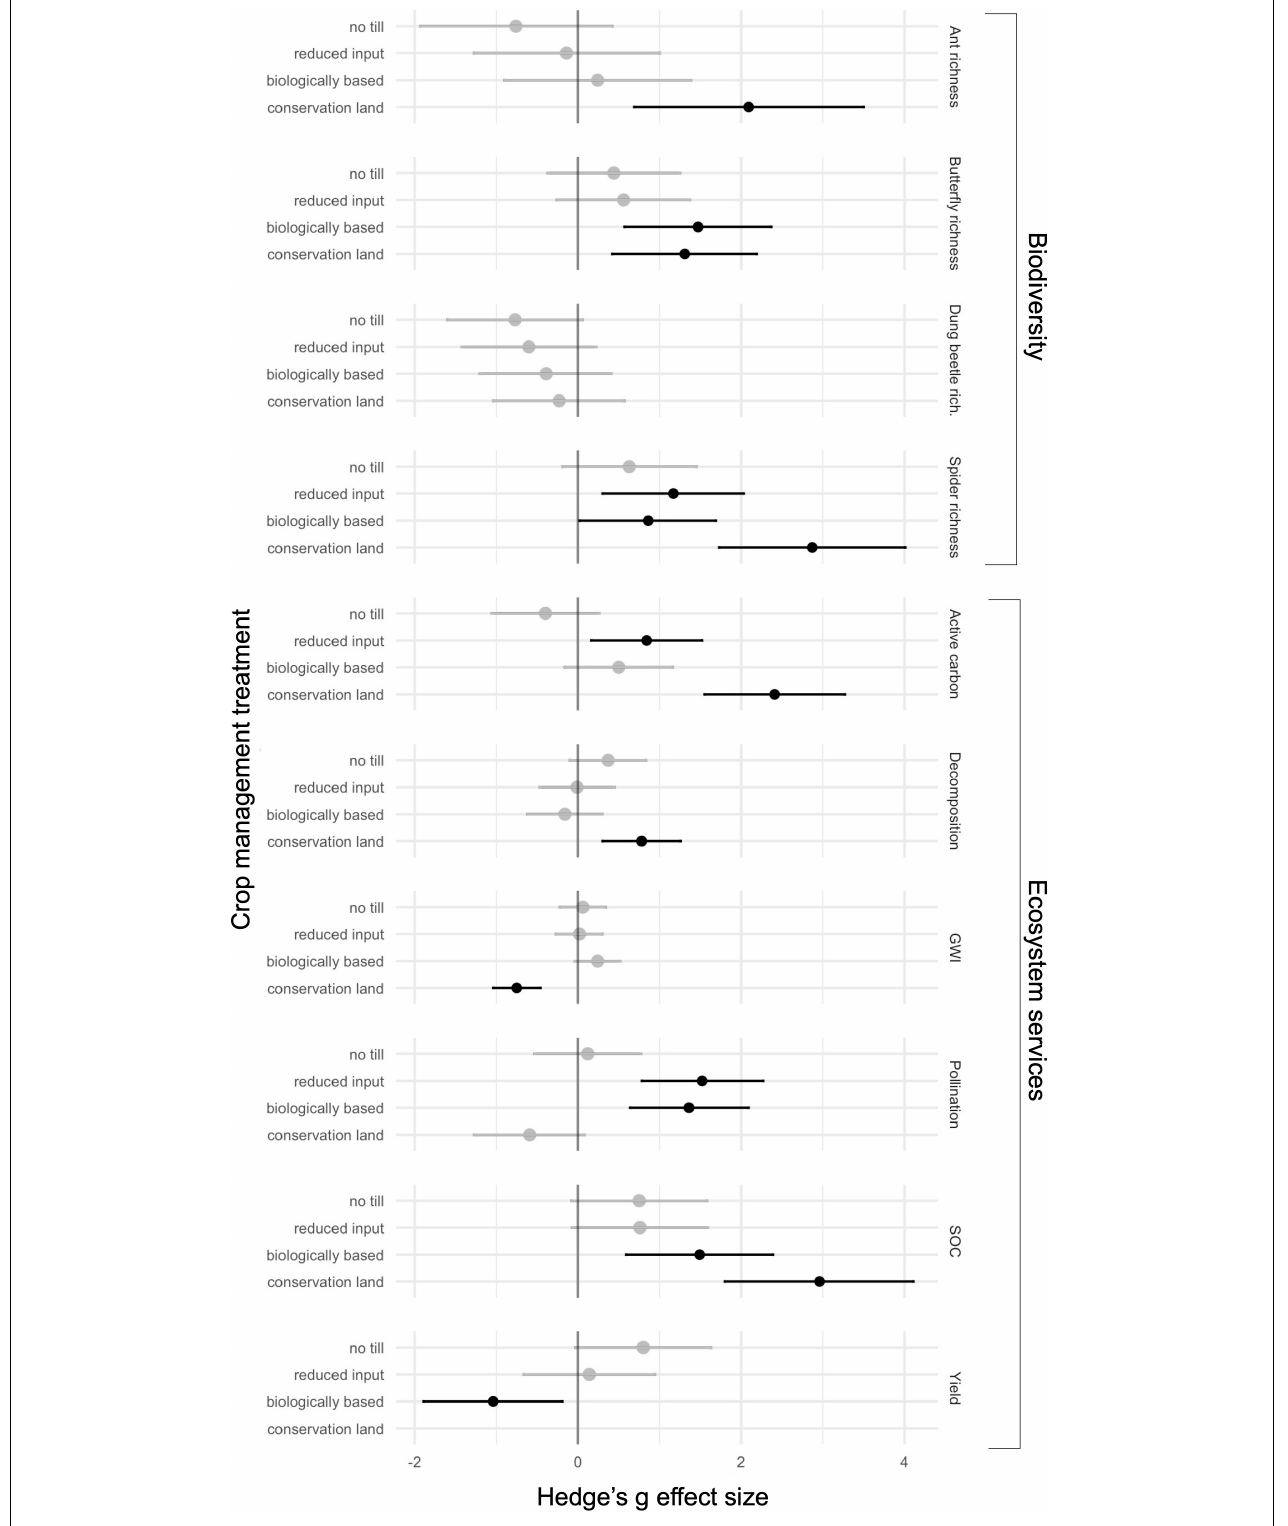
FIGURE 2 | Hedge’s g effect size (black and gray dots) with 95% confidence interval. The baseline is the conventional management treatment. Negative values are effect sizes lower than that of the baseline, and positive values are effect sizes higher than the baseline. Values that cross zero are shaded gray. Note that lower levels of global warming impact (GWI) would be a more positive ecosystem service. Conservation land was not harvested, therefore crop yield is not applicable for that treatment.